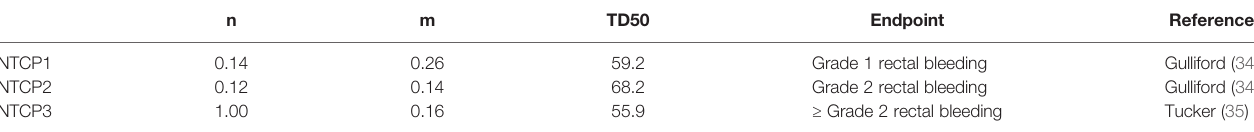
TABLE 2 | Parameters used in calculation of normal tissue complication probability (NTCP) for rectal toxicity. n m